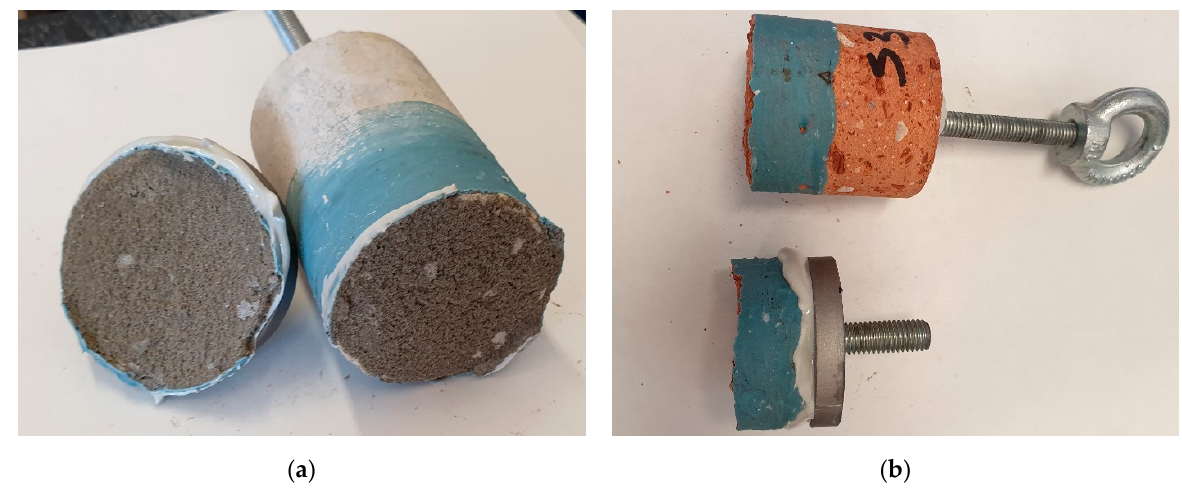
Figure 14. ( a ) Cohesive failure; ( b ) substrate failure.